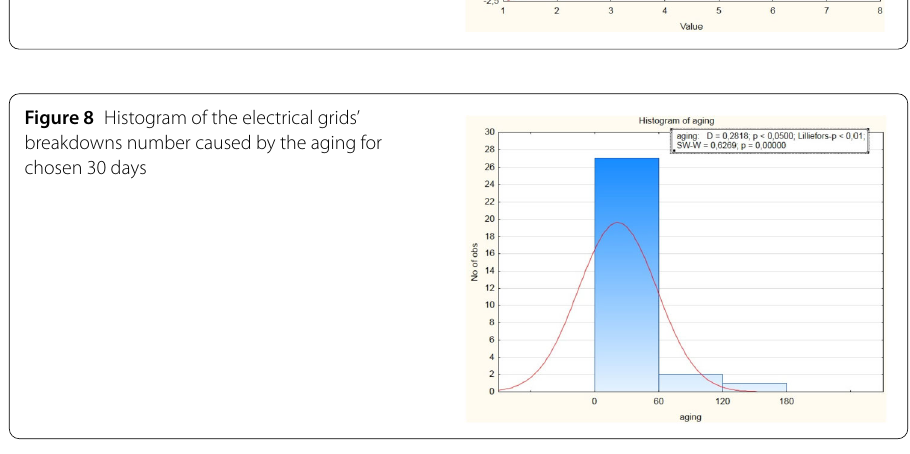
Figure 9 Histogram of the electrical grids’ breakdowns number having the unidentified reasons for chosen 30